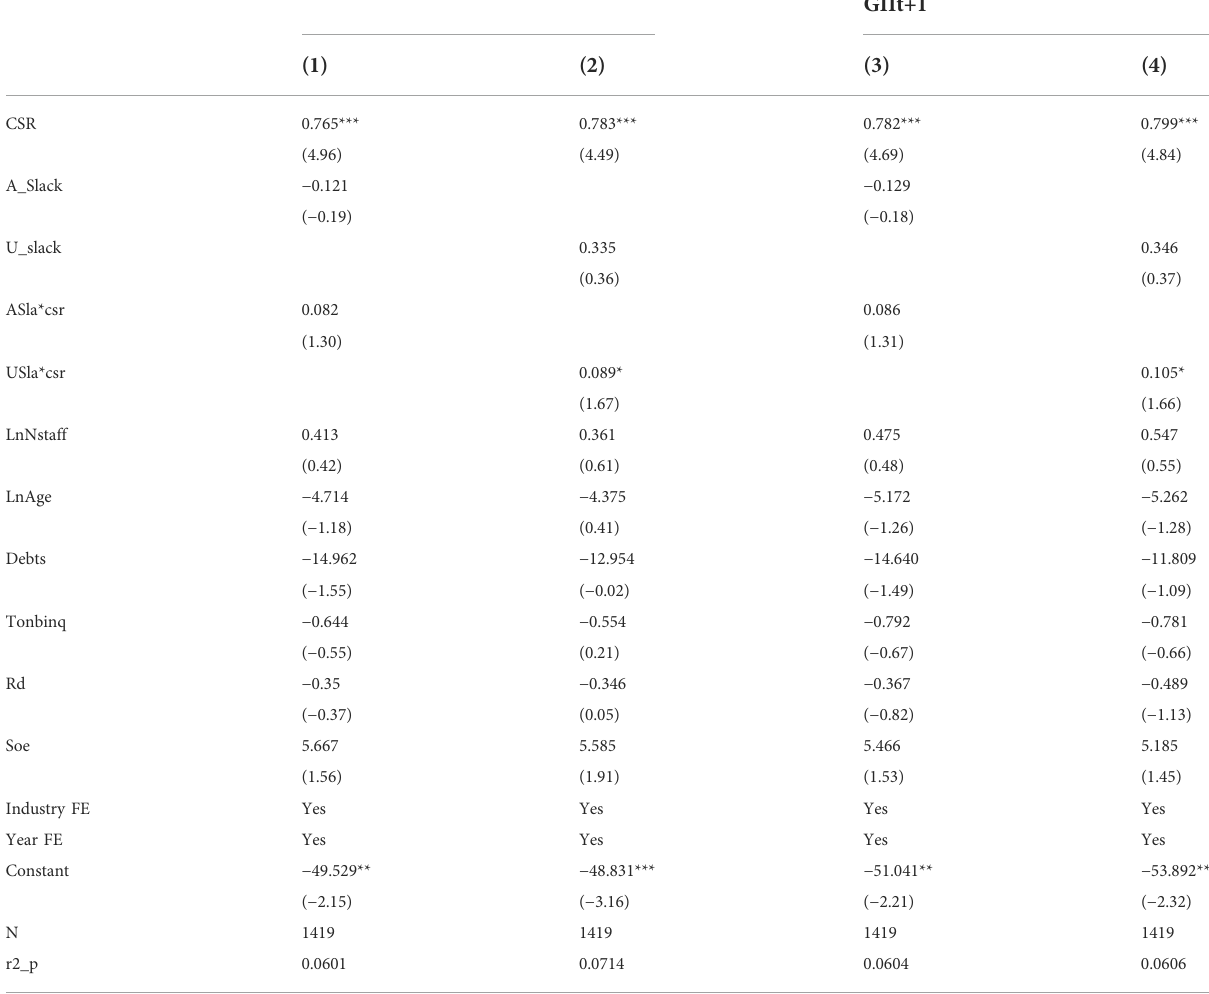
TABLE 5 The moderating effects of different types of slack